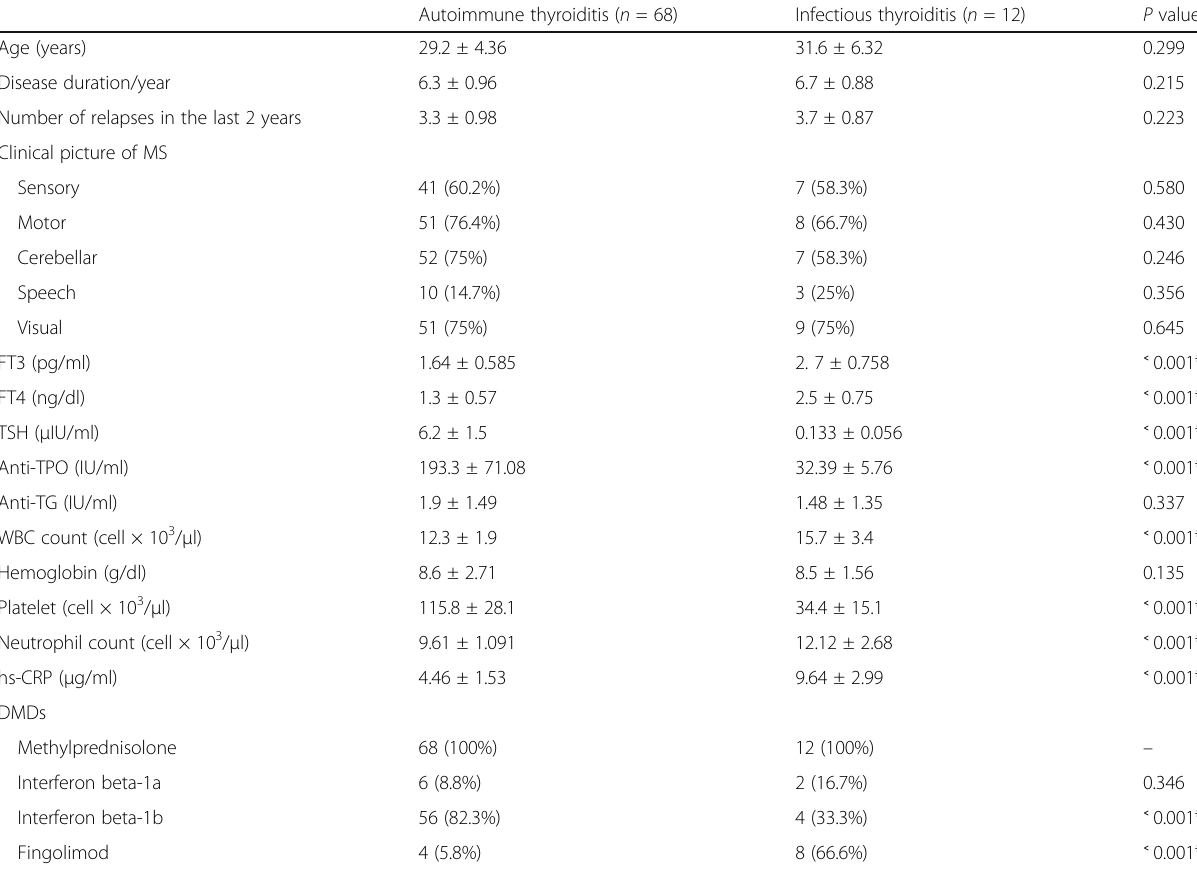
Table 2 Clinical and laboratory characteristics of patients with MS classified according to thyroid function tests